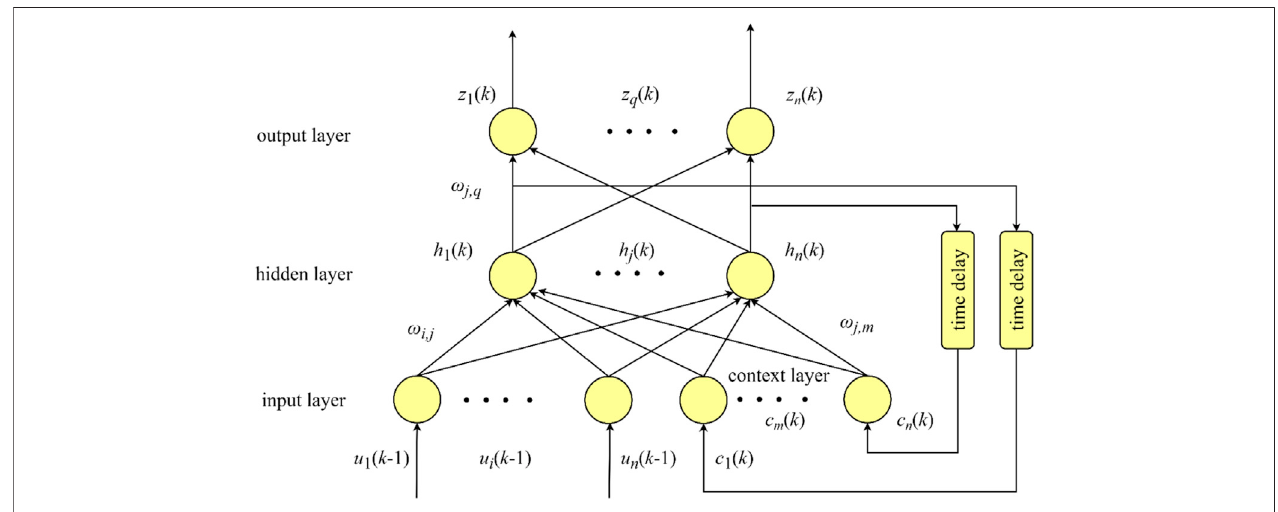
FIGURE 5 | Topology structure of Elman neural network.